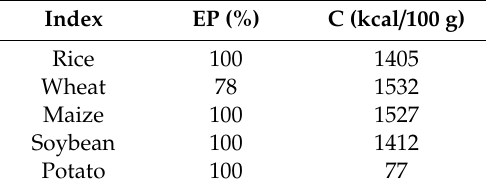
Table 3. The coe ffi cients for calculation of grain crop calories.